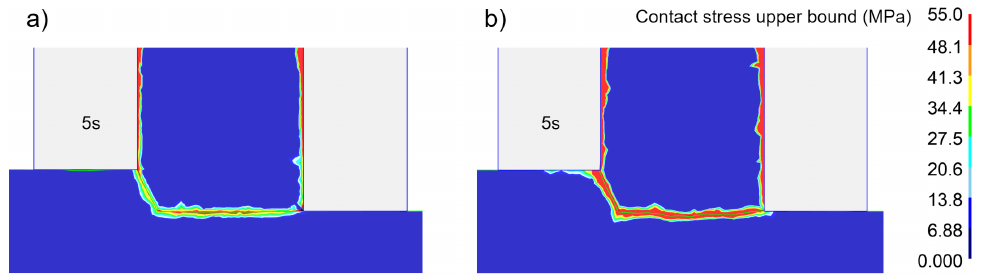
Figure 15. Normal pressure in a section through the die transverse to the feed direction. ( a ) balanced speed ratio; ( b ) high speed ratio, 20%